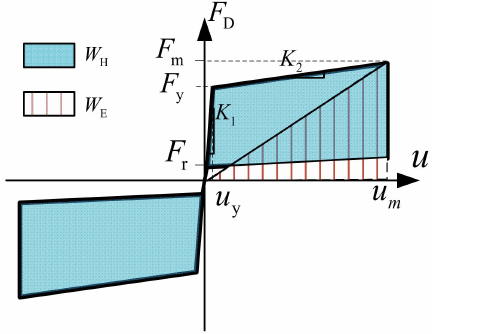
Figure 6. Force displacement relationship model of